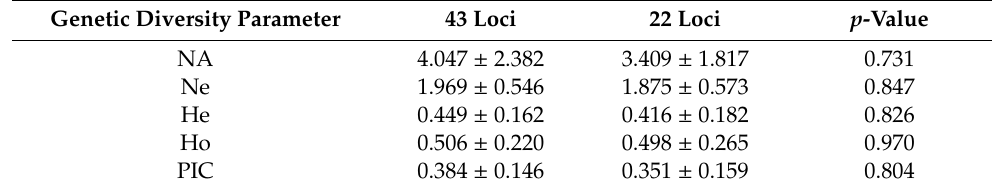
Table 4. Genetic diversity analysis of F1 generation of New Zealand white rabbits with two SSR marker combinations.